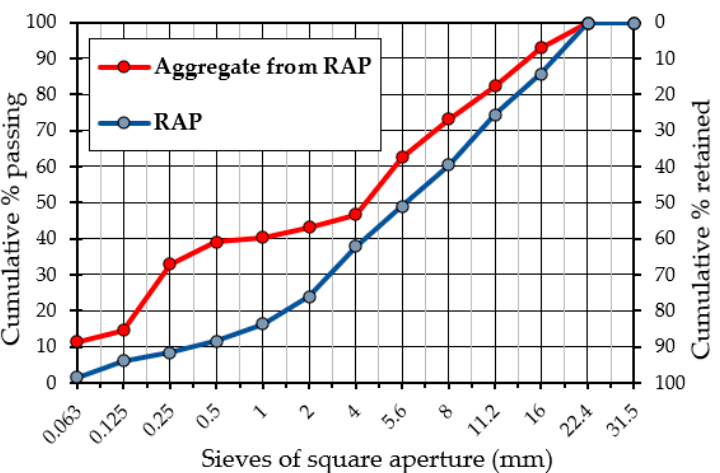
Figure 4. Particle size distribution of reclaimed asphalt pavement (RAP) used in mixture and aggregate from RAP (after extraction). Table 4. Grading of RAP used in mixture and aggregate from RAP (after extraction).